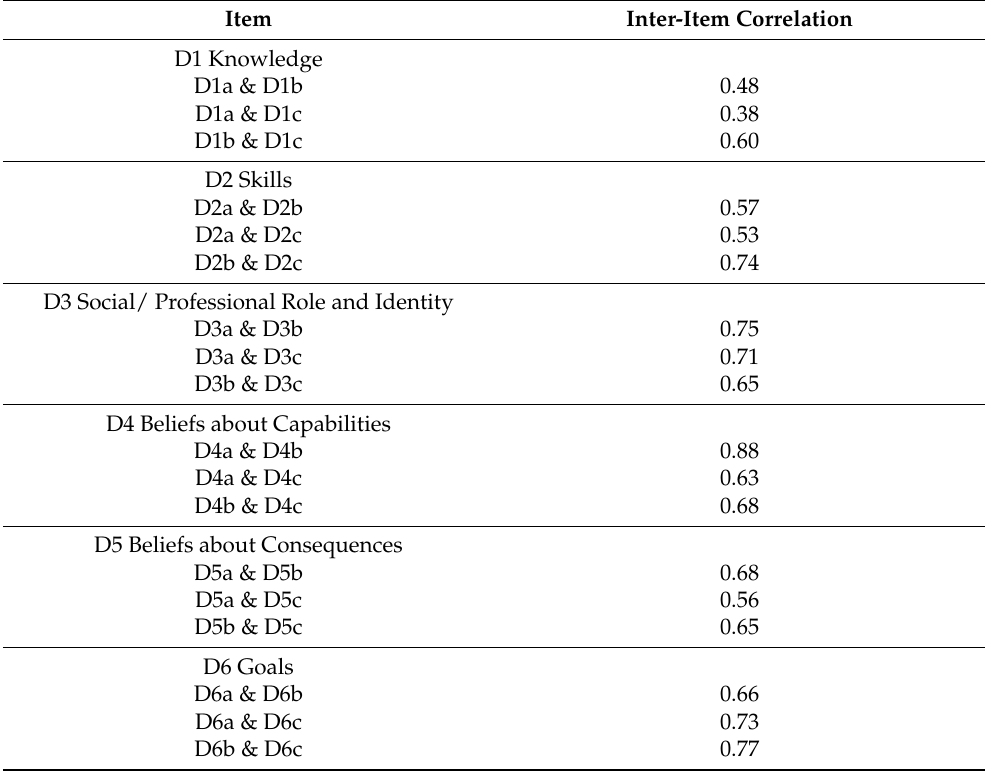
Table 4. Inter-Item